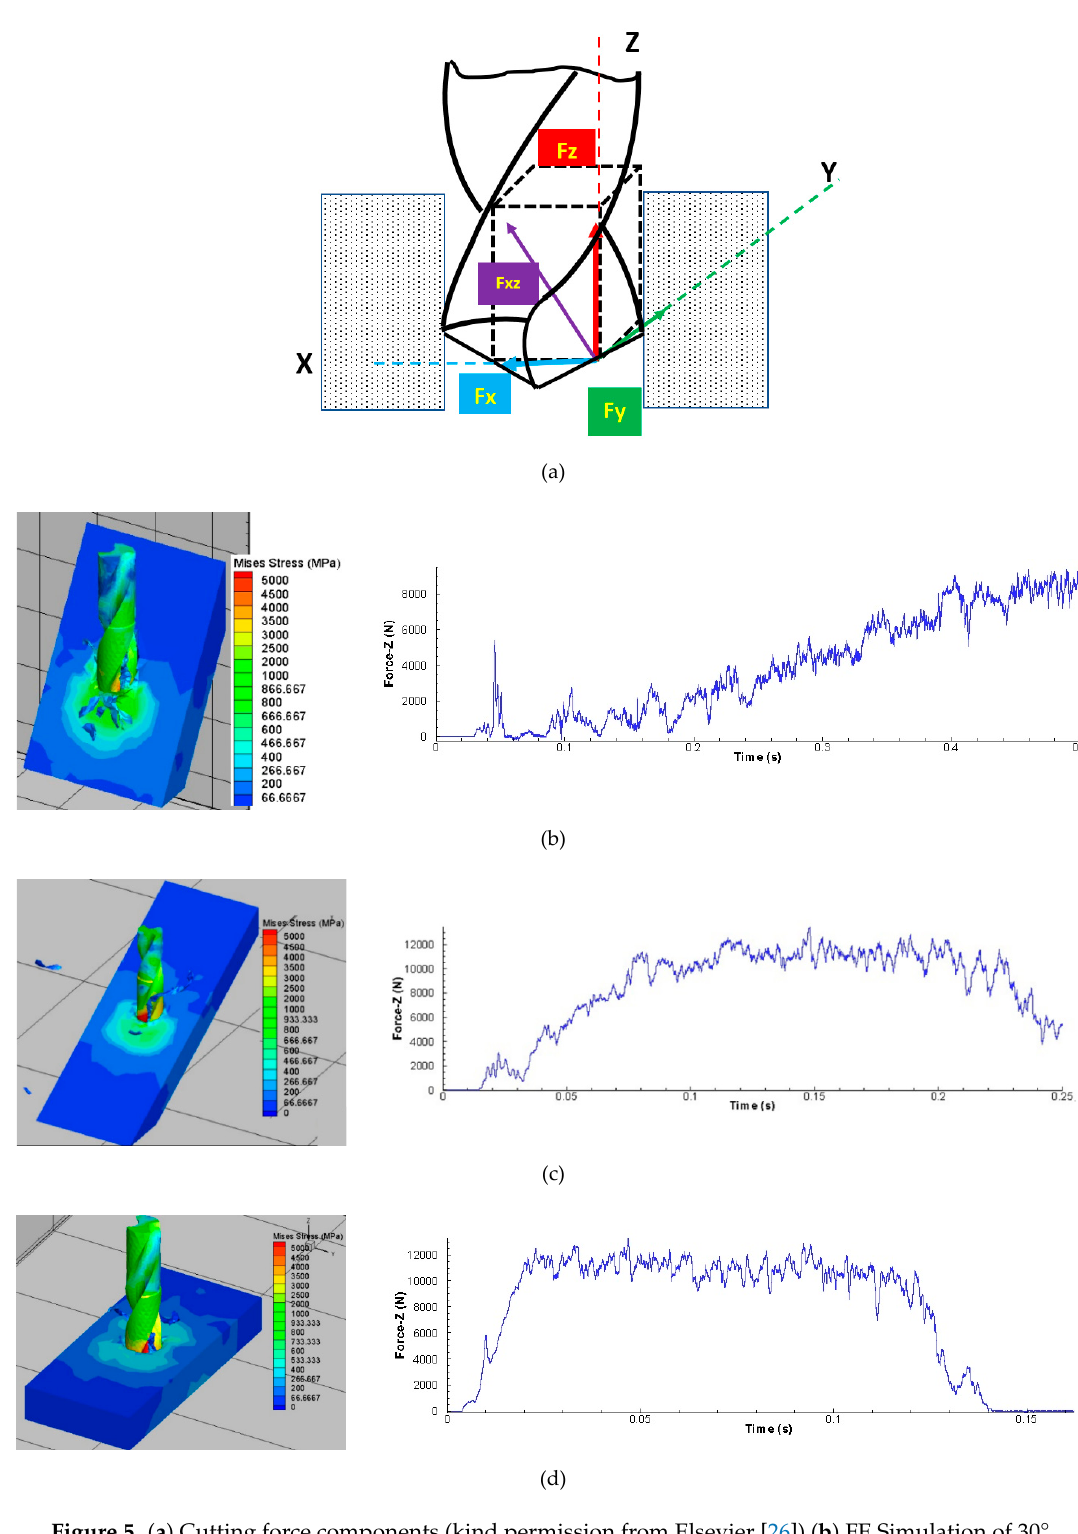
Figure 5. ( a ) Cutting force components (kind permission from Elsevier [26]) ( b ) FE Simulation of 30° inclination angle (0.5 mm/rev, 1000 spindle rpm) ( c ) FE Simulation of 60° inclination angle (0.5 mm/rev, 2000 spindle rpm) ( d ) FE Simulation of 90° inclination angle (0.5 mm/rev, 3000 spindle rpm).